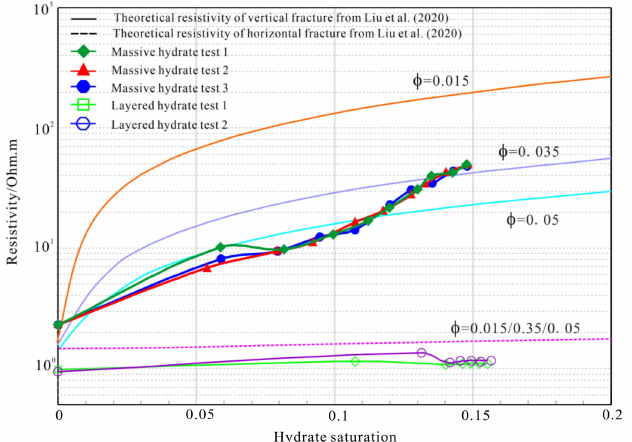
Figure 6. Comparisons between experimental results and the theoretical resistivity of gas hydrate- filled fractures from Liu et al., (2020)